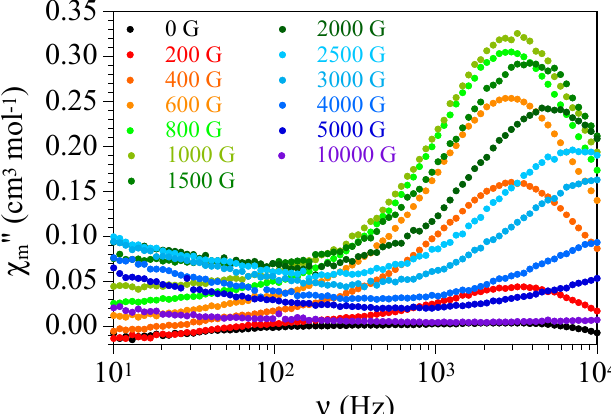
Figure 5. Frequency dependence of the χ m ′′ signal for compound 1 at 2 K with different applied DC fields.